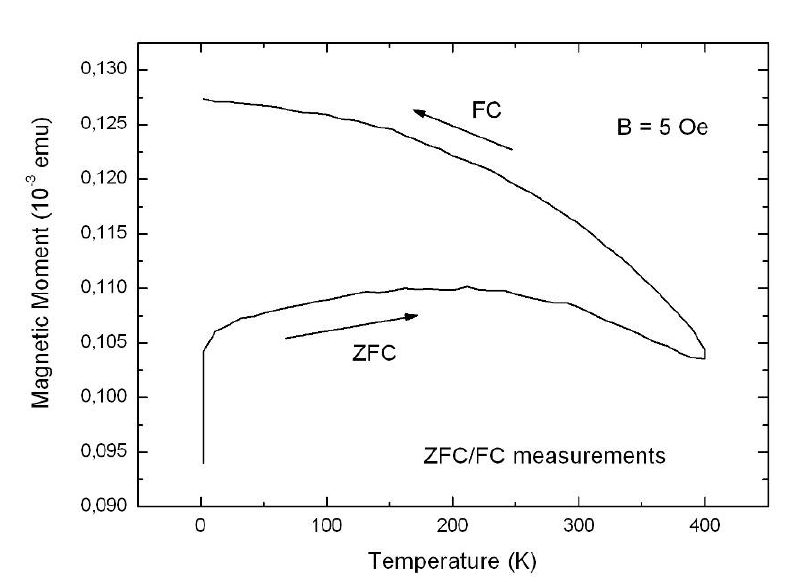
Figure 33. For comparison to Figure 32 ZFC/FC measurements of a PS-sample with a large amount of densely packed Ni particle deposition is investigated. The shallow increase of the ZFC-branch without the presence of a distinct peak indicates strong coupling between the Ni-structures